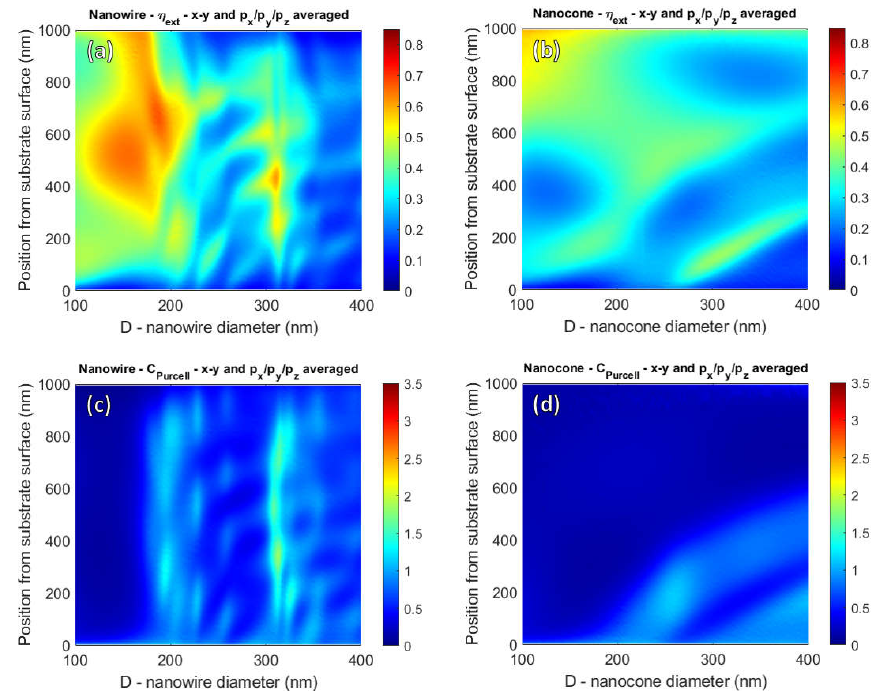
Figure 3. ( a , b ) Extraction efficiency, η ext , and ( c , d ) Purcell factor, C Purcell , for ( a,c ) a nanowire and ( b,d